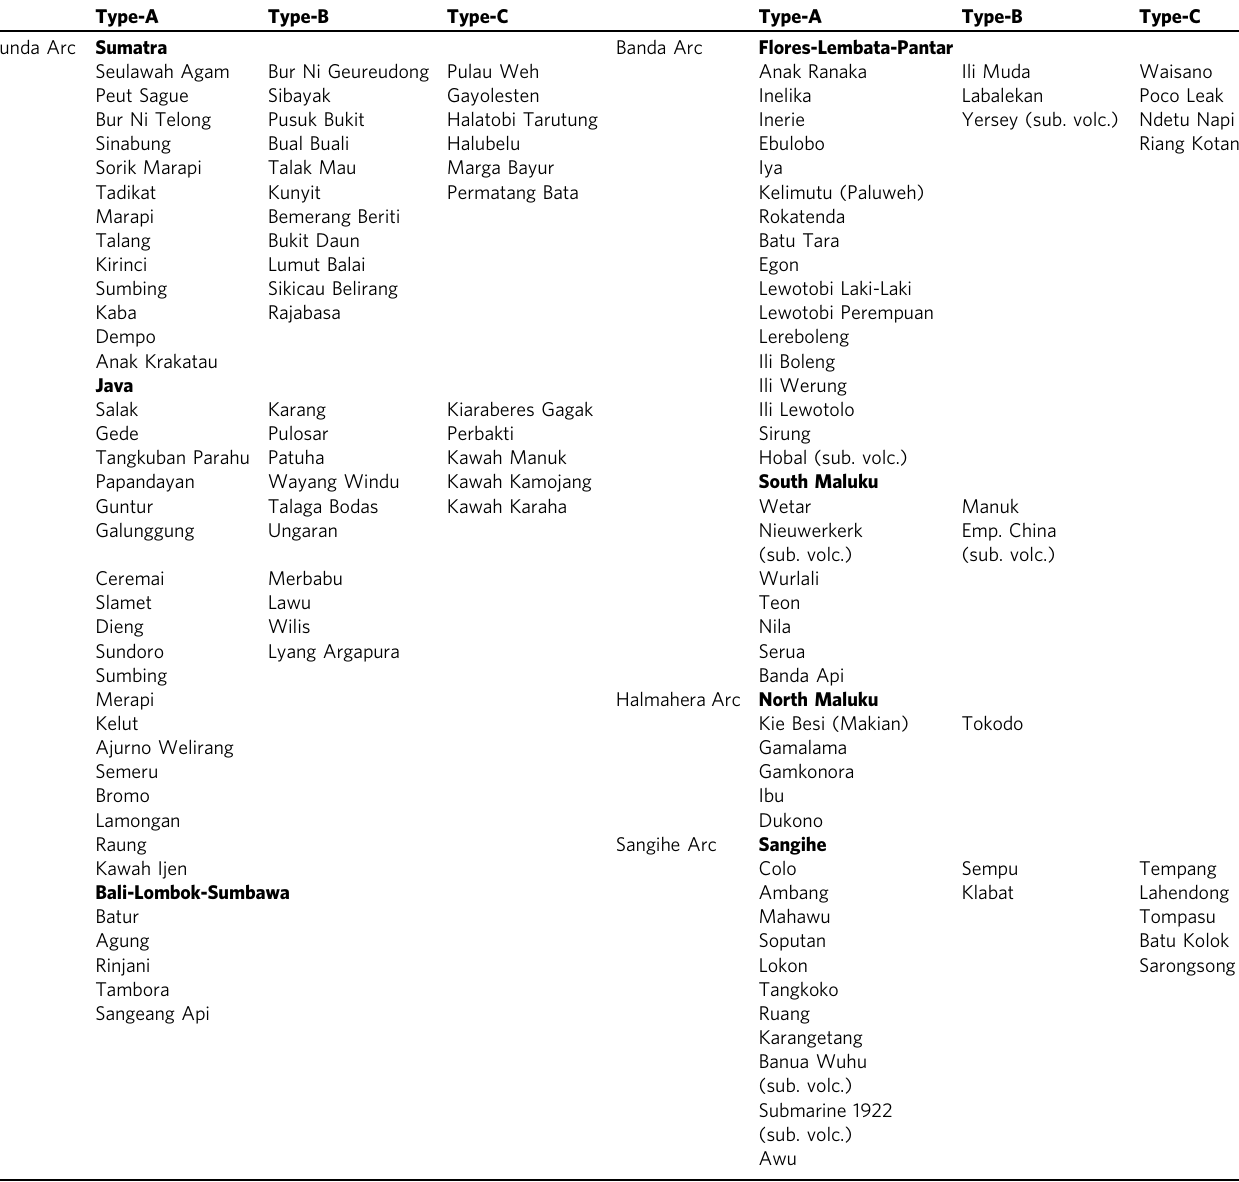
Table 2 The distribution of the Indonesian active volcanoes per type (A, B or C), region and arcs.